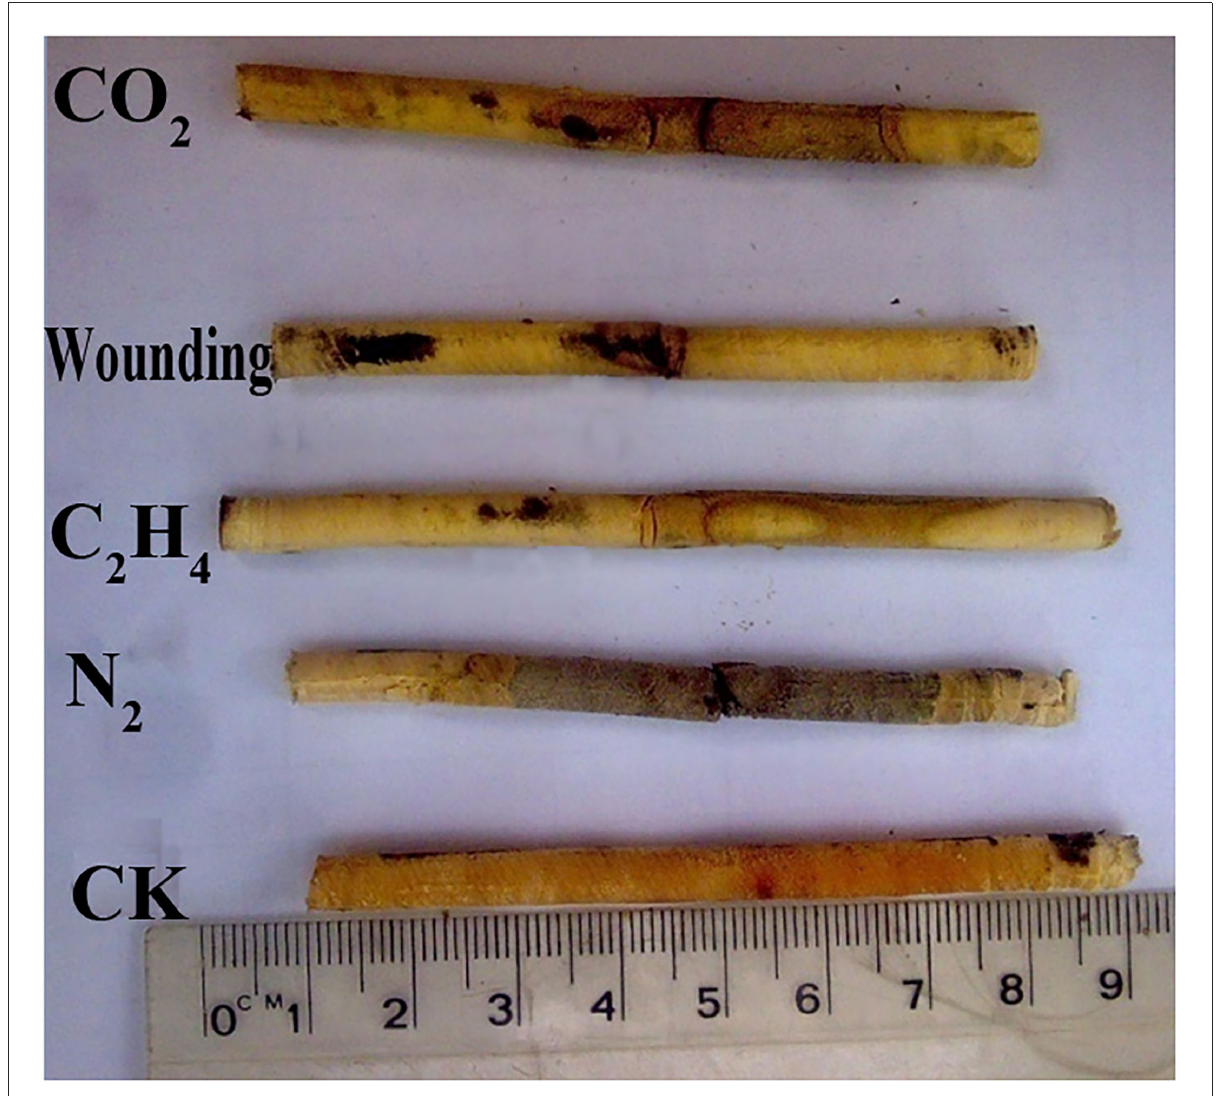
FIGURE2 Core samples induced by different gas treatments (CO 2 , wounding, C 2 H 4, and N 2 ). Cores were taken from 1cm above the drill hole; CK corresponds to the control group of young sandals at the same height. Ruler = 10cm.